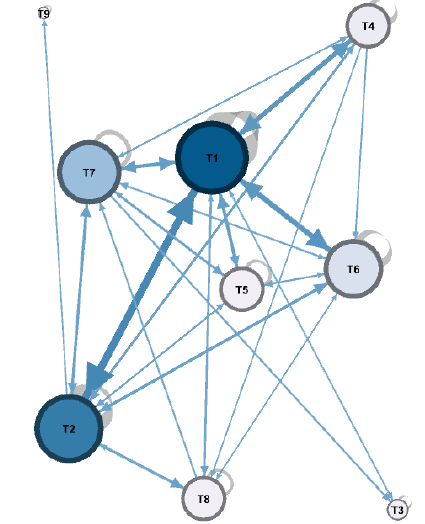
Figure 5. Word clouds with the 10 most frequently